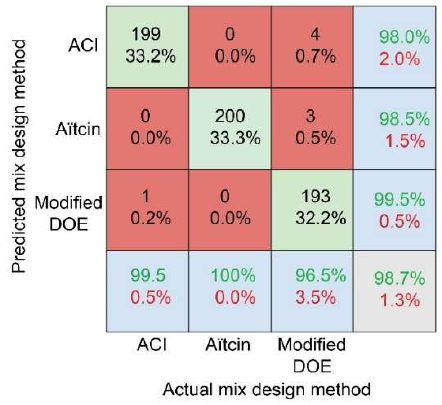
Figure 5. Evaluating the performance of the tree classifier using confusion matrix on testing data.